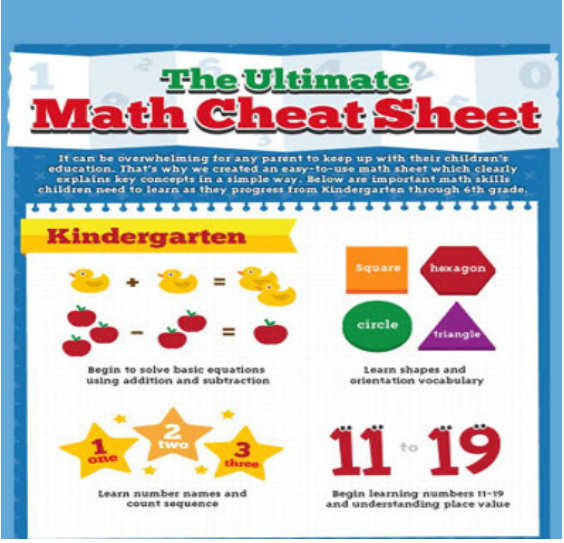
Figure 3. An infographics for teach - ing mathematics. Retrieved from: http://el - earninginfographics.com/the-ultimate-math-